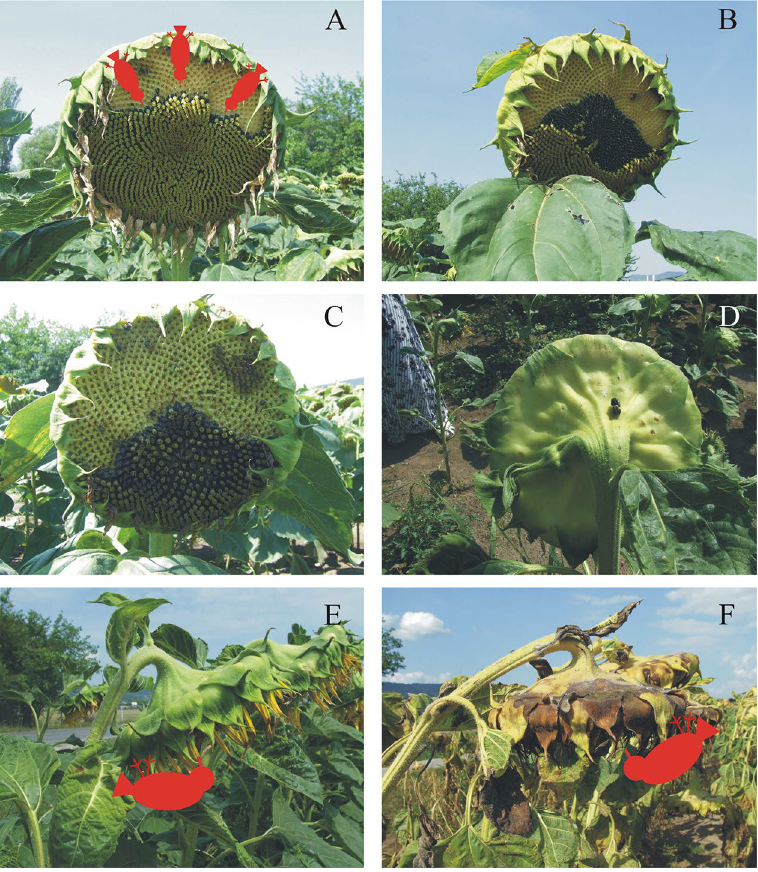
Figure 6. Bird-depredation of sunflower seeds. ( A – C ) The seeds of more elevated sunflower heads can be easier picked by birds (red schematic) clinging onto the head’s edge. ( D ) Dark excrement of a seed-eating bird on the back of a sunflower head. ( E , F ) The seeds of more downward-facing sunflower heads are more difficult for birds to reach. The yellow holes of picked-off dark grey seeds are clearly visible in pictures ( A – C ). Photos were taken by Gábor